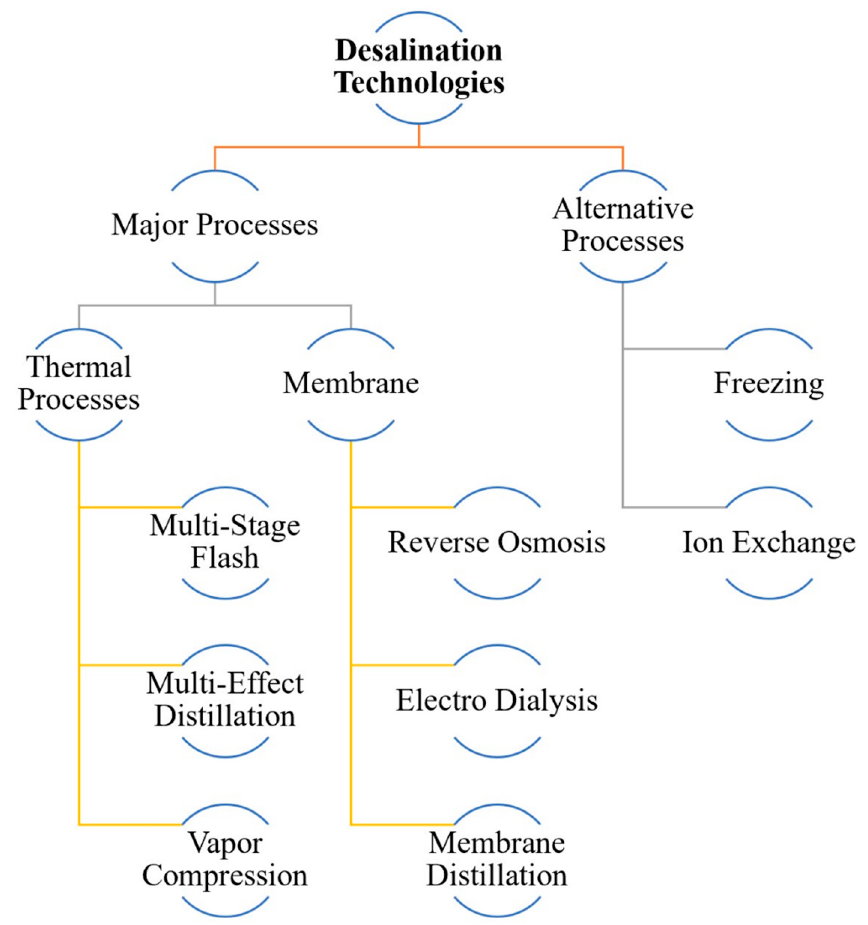
Figure 5. A Schematic diagram of the desalination technologies, updated from [82].